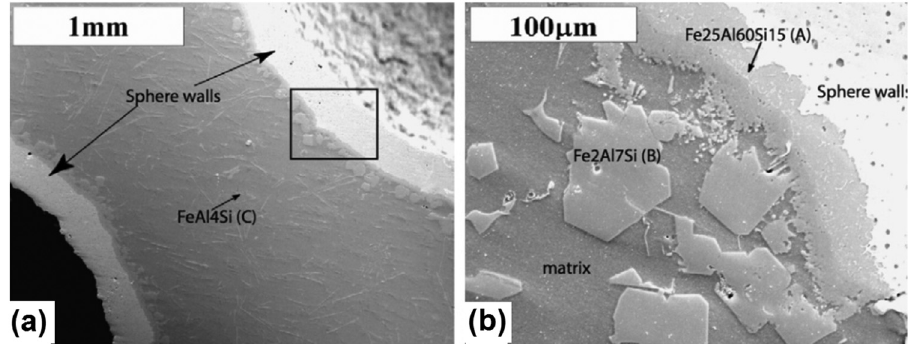
Figure 12: SEM images of an Al – 12Si alloy reinforced with hollow steel spheres, processed by casting. ( a ) Spheres with their walls, and matrix with FeAl4Si are clearly observed. ( b ) Sphere/matrix interface with the presence of di ff erent phases ( Reproduced with permission from [ 59 ] . )